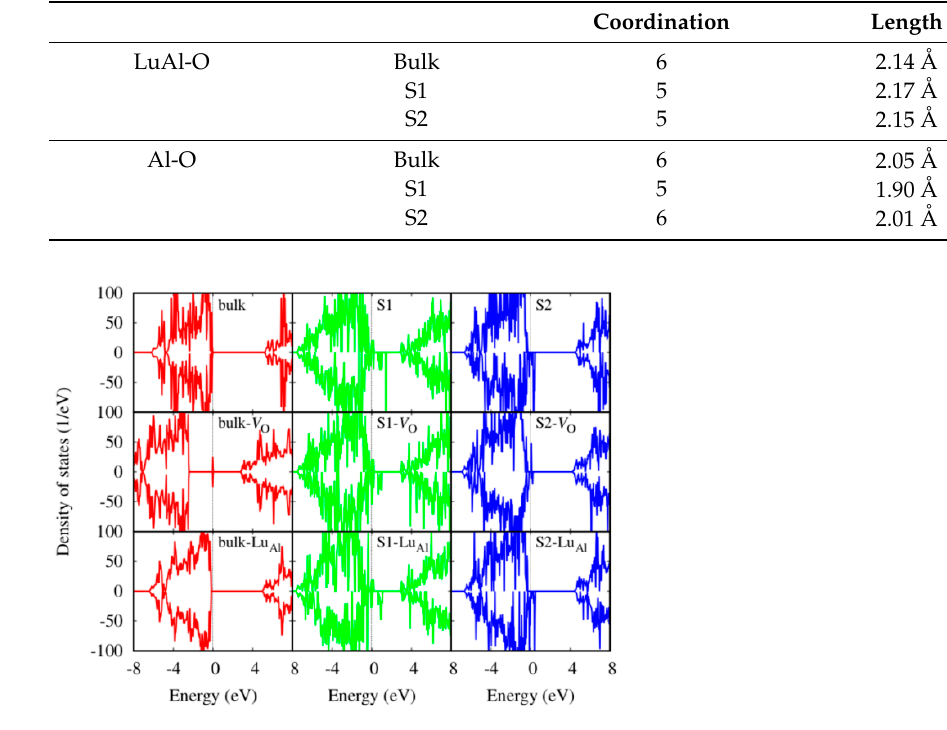
Figure 4. Density of states for the bulk and surfaces without and with defects. The Fermi energy level is set to zero.